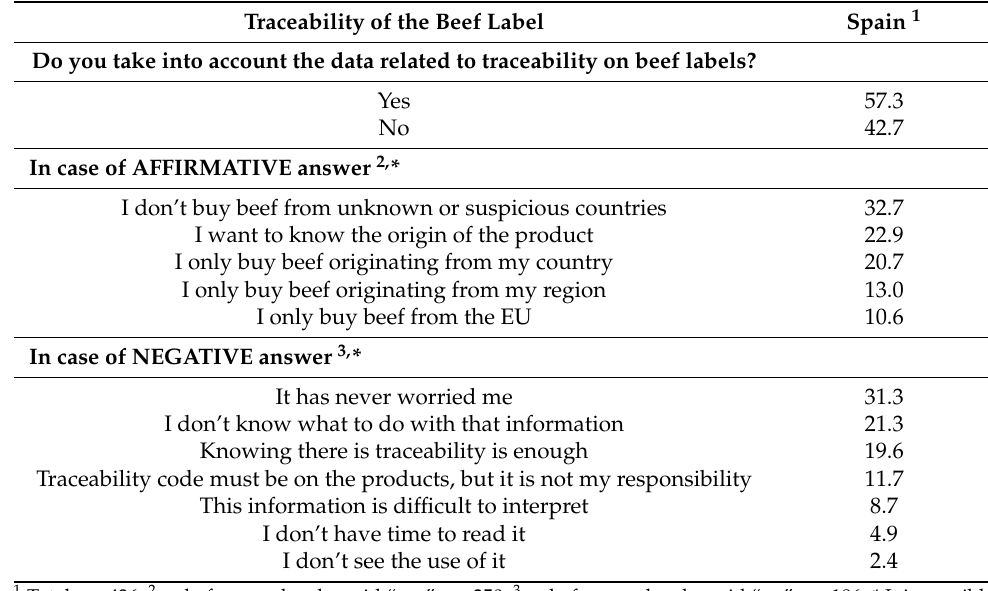
Table 4. Opinion of Spanish consumers on information related to the traceability in beef labels. Traceability of the Beef Label Spain 1